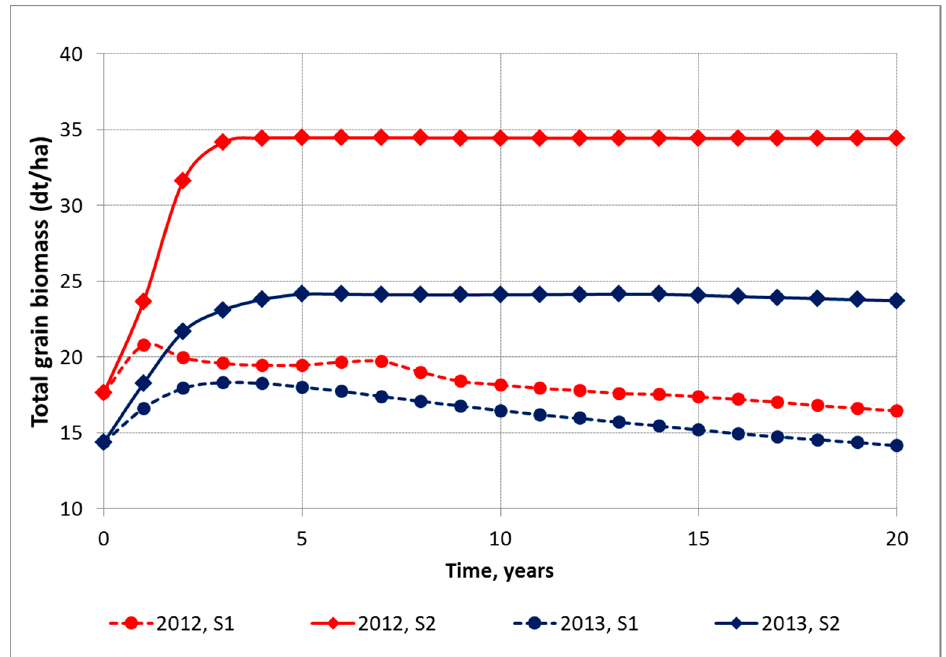
Figure 3. Long-term dynamics of plant productivity under different land use strategies for two benchmark weather realizations. Plant—spring wheat. Weather datasets—2012, 2013 vegetation periods in Men’kovo Experimental Station (Leningrad Region, Russia). S1—traditional technology—all above-ground biomass removed from the field, S2—“green manure” technology—all above-ground biomass remained on the field.